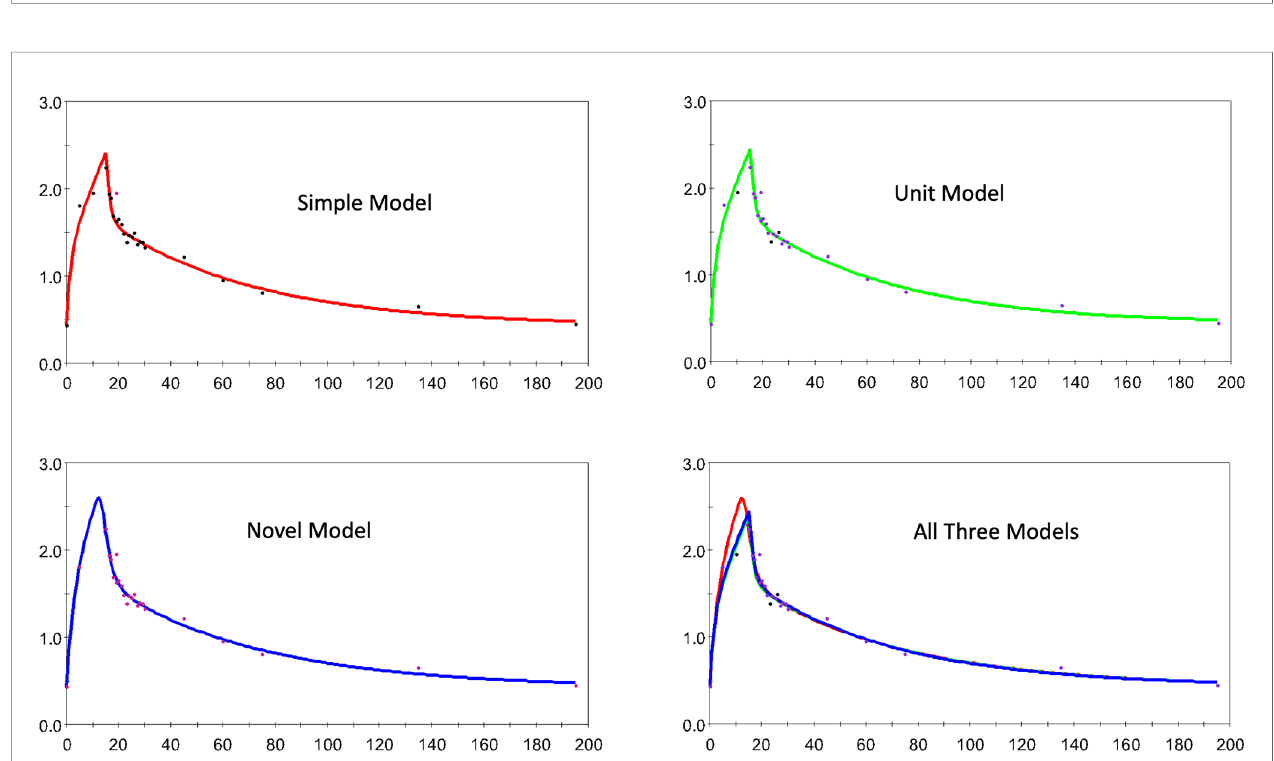
FIGURE 3 | The estimated and observed lactate disposition for the S, U, and N models separately, and all models together are shown for horse 5. Note uniform offset to pre-infusion mean lactate